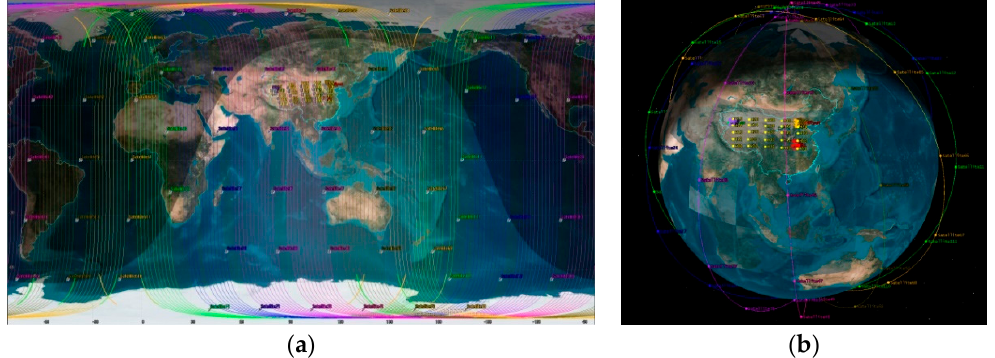
Figure 6. Network architectures in STK. ( a ) 2D network model; ( b ) 3D network model.